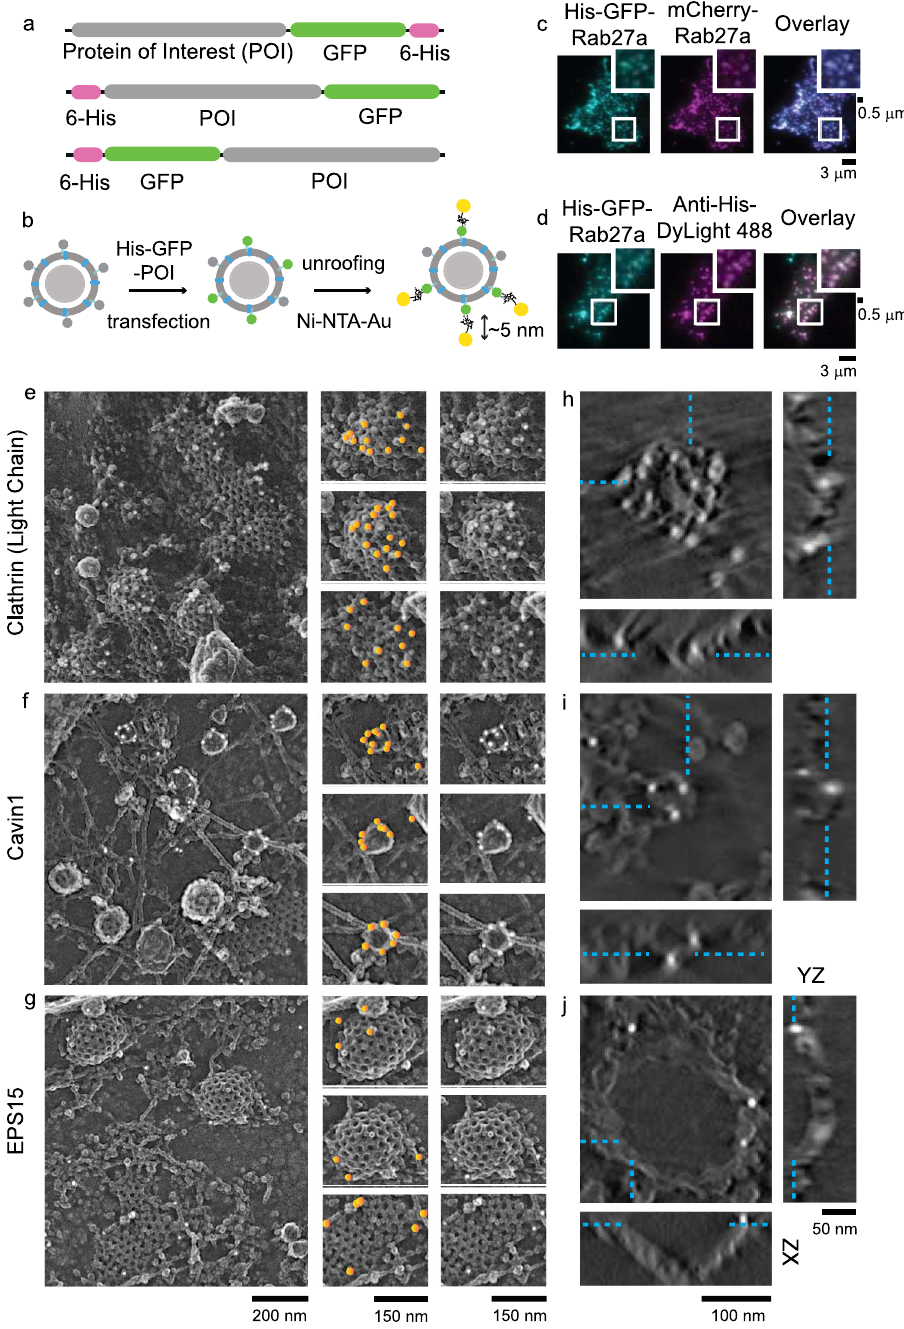
Fig. 3 Nanogold-based platinum replica protein labeling at the plasma membrane. a A schematic of plasmids used for the protein of interests (POI) with histidine and GFP fused at the N or C terminal domains. b Scheme showing dense-core vesicle-associated protein labeled with Ni-NTA-Au. c His-GFP- Rab27a, mCherry-Rab27a, and overlay images, showing colocalization with DCVs. d Colocalization of His-GFP-Rab27a and Anti-Histidine-DyLight 488 showing the accessibility of histidine epitope. The validation experiments were done once. Scale bars are 3 μ m. Enlarged small section (white box) for each image is at the top right corner. Scale bar is 0.5 μ m. Platinum replica images of HeLa cells (crop from larger PREM image of a cell in Supplementary Fig. 12) expressed with e His-GFP-Clathrin Light Chain A, f His-Cavin-GFP, and g EPS15-GFP-His. Left panel scale bar is 200 nm. Enlarged images in the middle panel show gold particles on endocytic structures marked with orange circles. The same enlarged images in the right panel show the structures without orange markings. Scale bar is 150 nm. Tomogram section ( XY view, scale bar = 100 nm) of an individual clathrin structure labeled with Ni-NTA-Au for h clathrin light chain A, i cavin1, and j EPS15, and the orthogonal views in XZ (scale bar = 100 nm) and YZ (scale bar = 50 nm) dimensions. Cyan dashed lines mark the gold particles seen in XY view of a z slice and denote their location in orthogonal views. Two independent imaging experiments were performed for 2D- and